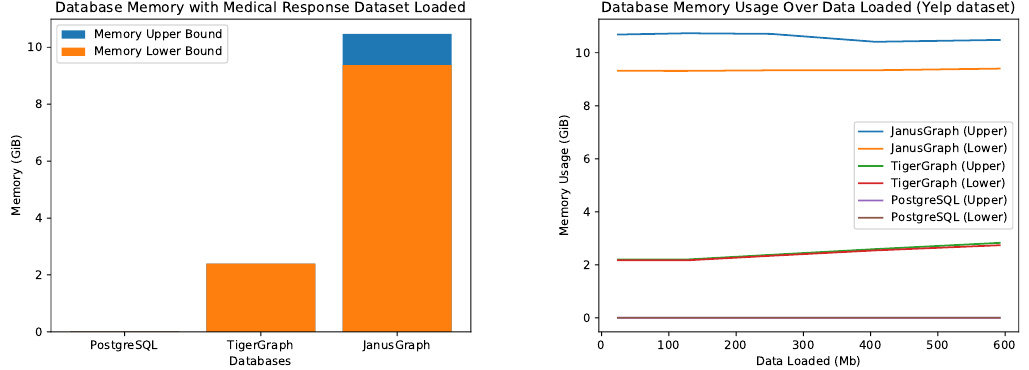
Figure 11. Database memory usage for each dataset. The medical response dataset is 1.5 Mb